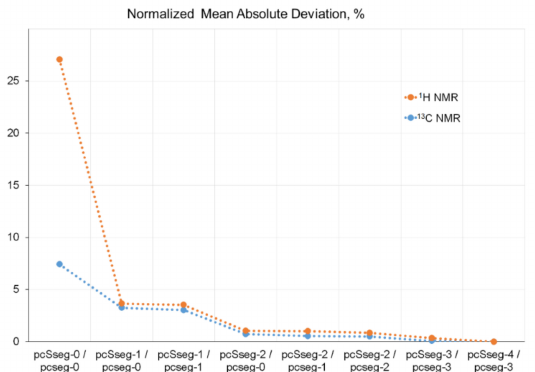
Figure 5. Normalized mean absolute deviations of 1 H and 13 C-NMR shielding constants of strychnine ( 2 ), calculated using different locally dense basis set schemes based on segmented Jensen’s basis sets. Reproduced from Semenov and Krivdin [67] with the permission of John Wiley and Sons.